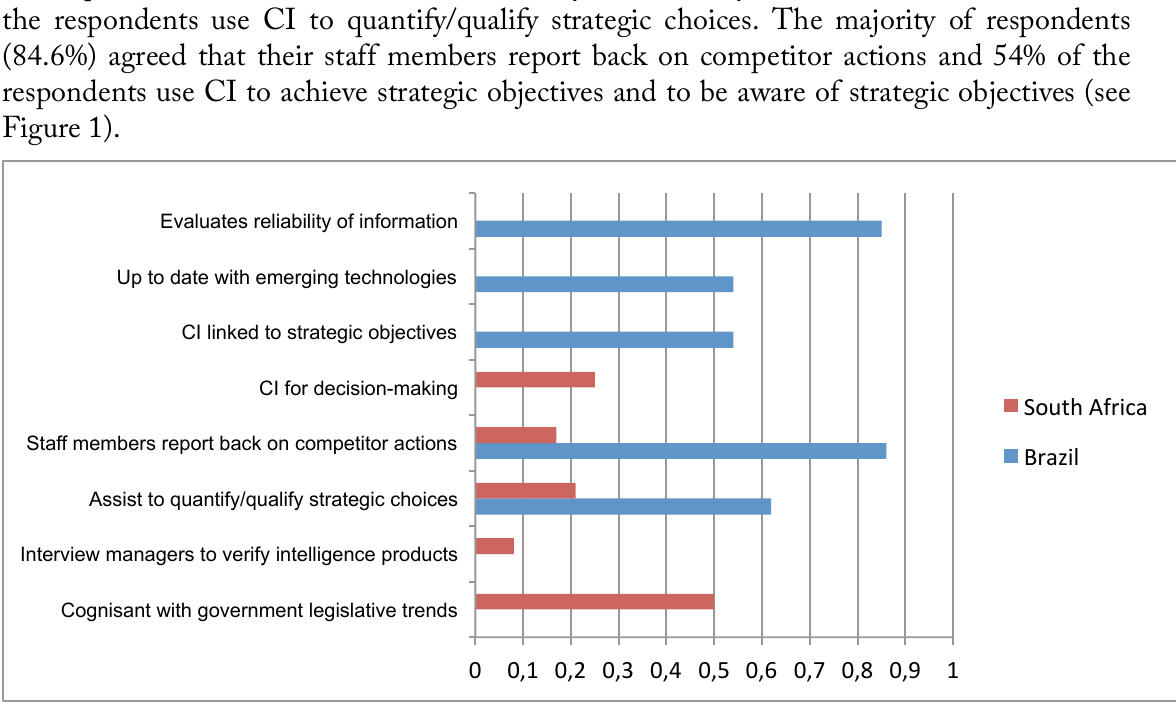
Figure 1: Five most important CI